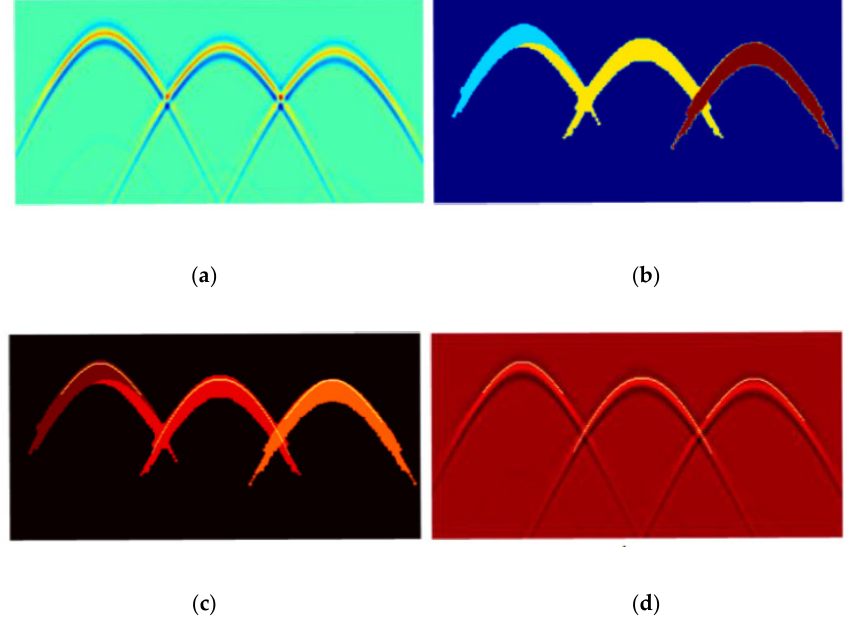
Figure 17. Results of our segmentation method. ( a ) The example in Figure 16. ( b ) The output from the symmetry test labeling with different colors. ( c ) The result of the hyperbola fitting on ( b ). ( d ) is the result of the hyperbola fitting showing on ( a ).